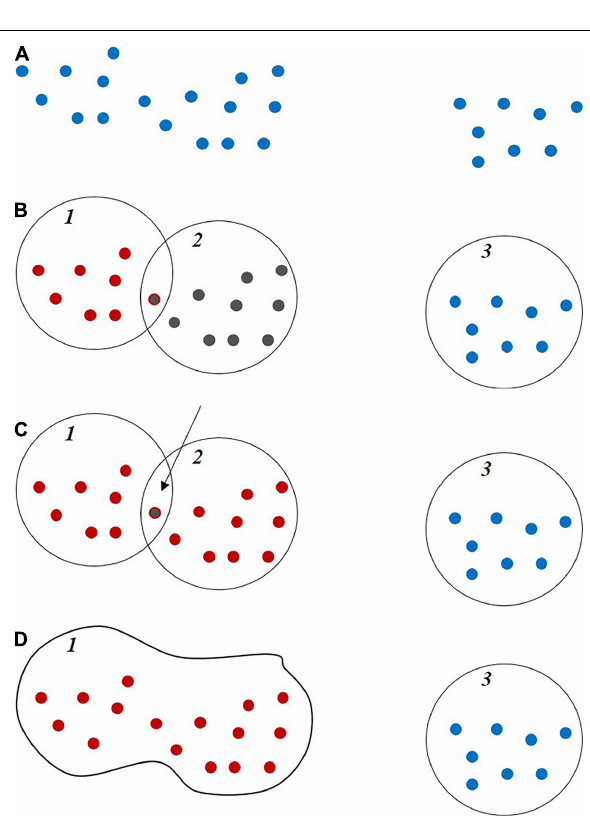
FIGURE 8 | Thematic region growing clustering steps: (A) Sample points. (B) Initial clustering. (C) Finding common points in two close clusters. (D) Connecting and joining two